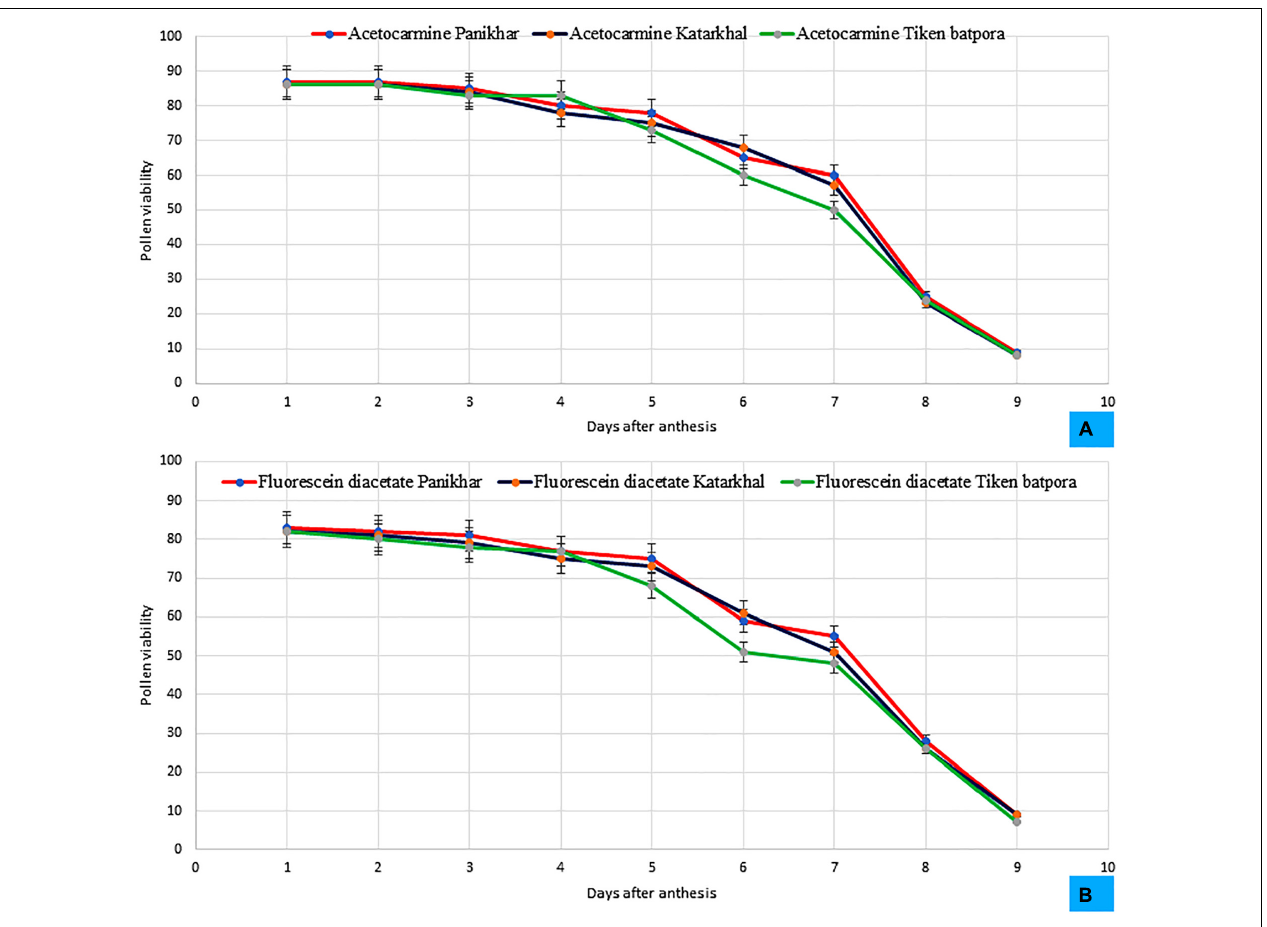
FIGURE 4 | Pattern of the pollen viability at different populations observed in (A) 1% acetocarmine, (B) Fluorescein diacetate (FDA) (bars represent SD for n = 20